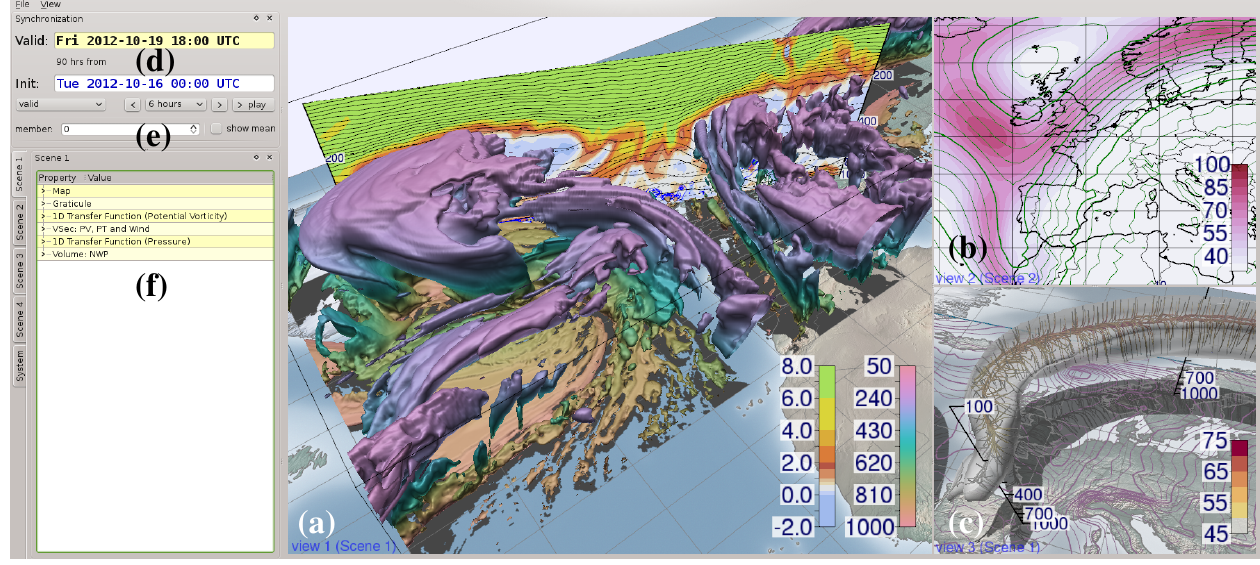
Figure 2. The main user interface of Met.3D. We apply 2-D and 3-D visualization techniques to explore ensemble weather forecasts. (a) Isosurfaces of cloud cover fraction of 0.5 coloured by elevation (hPa), and a vertical section of potential vorticity (PVU). (b) Horizontal section with contour lines of the mean geopotential height field (m) and filled contours of its SD (m). (c) Normal curves applied to the wind field to visualize the jet core. The white isosurface shows 45 ms − 1 . Colour coding in ms − 1 . (d–f) See text for